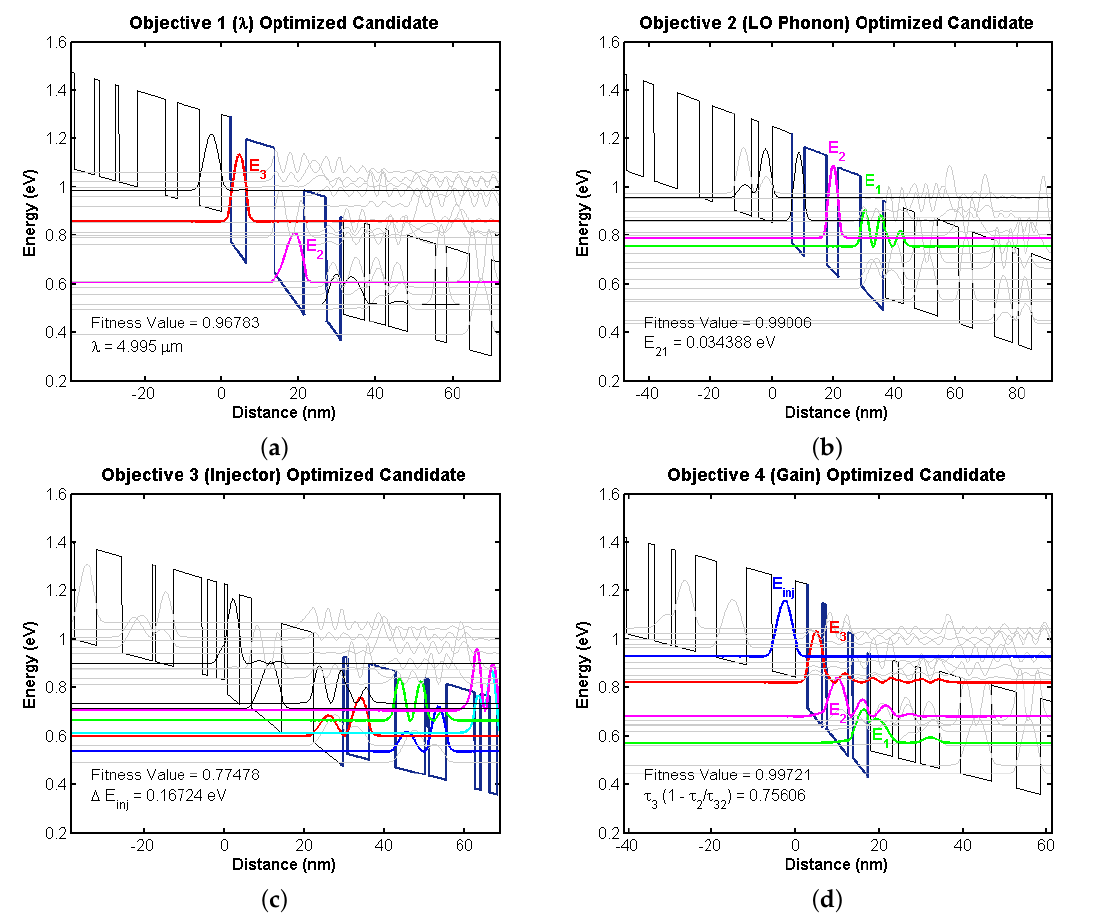
Figure 13. Al x Ga 1 − x As/In y Ga 1 − y As QC laser candidates simulated on GaAs (111) with top fitness rank for ( a ) wavelength, ( b ) LO phonon, ( c ) injector coupling, and ( d ) gain objectives given a random initial